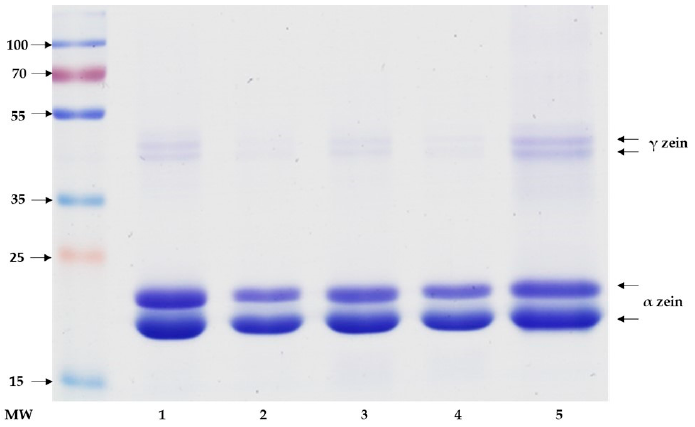
Figure 1. Polyacrylamide gel of the native zein extracts. Protein bands are observed between the molecular weights of 20 and 25 kD in all samples. In addition, two bands of approximately 45 and 48 kD can be seen. (1) Teo, (2) Nat, (3) Hyb, (4) HT, (5) Zein (Sigma-Aldrich, Z3625). MW—molecular weight.